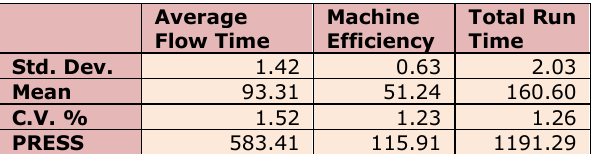
Table 8. Summary statistics on average flow time, machine efficiency and total run